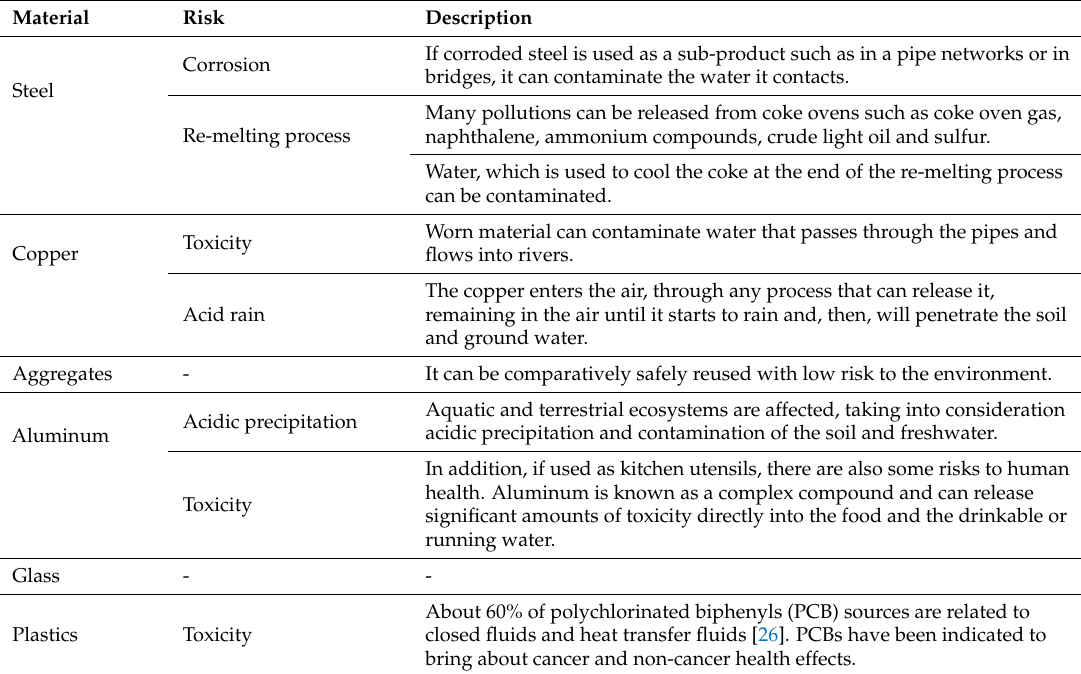
Table 5. Emerging risks of recycling and reusing aging